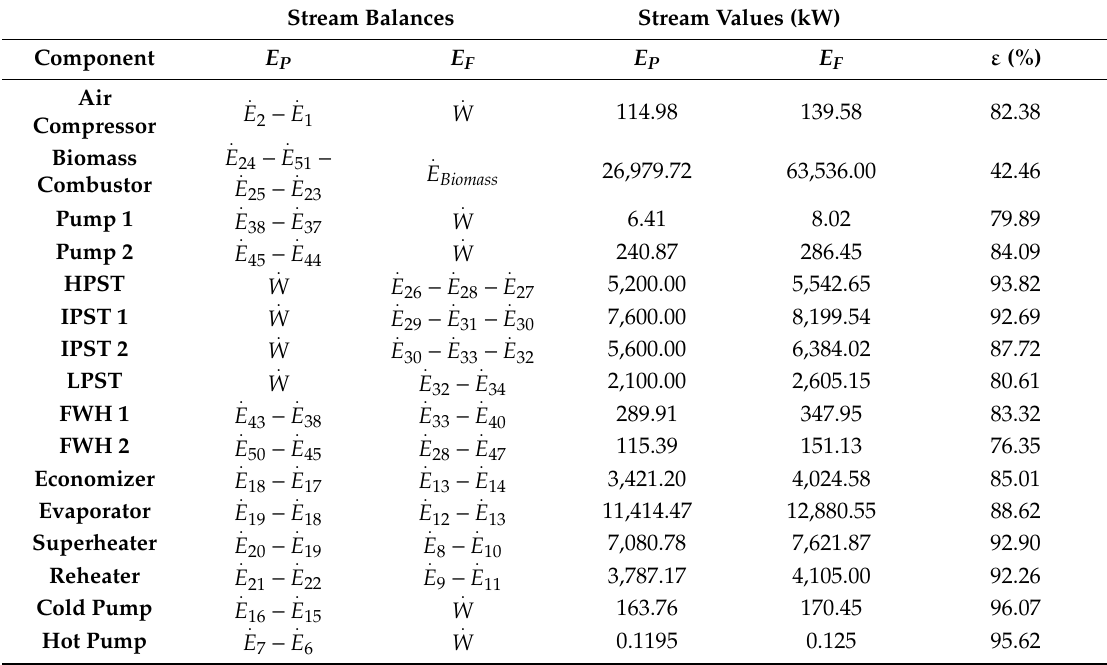
Table 2. Exergetic e ffi ciencies of power plant